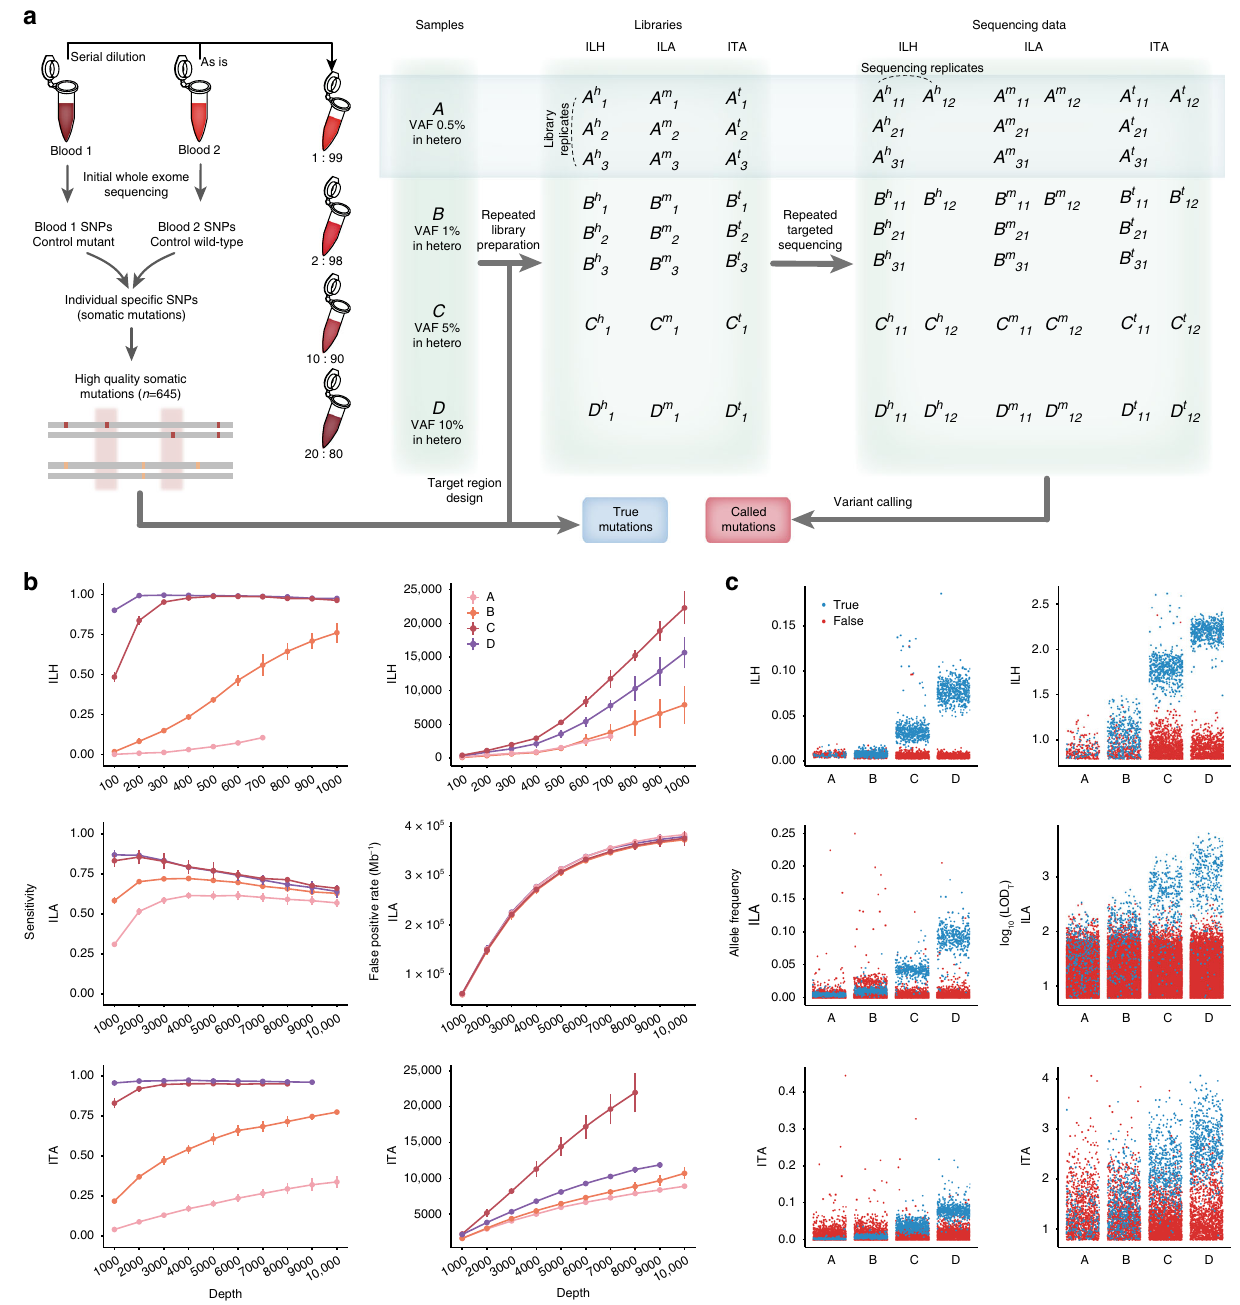
Fig. 1 Assessment of conventional algorithms for detecting mutations with low-allele frequency. a Schematic of experimental design for test-base sequencing data. Four distinct sample mixtures (A, B, C, and D) were prepared and sequenced with three different sequencing platforms (ILH, ILA, and ITA). Constructed libraries from each platform were sequenced twice to produce sequencing replicates (X 11 and X 12 ). For samples A and B, two independent sets of sequencing library were additionally prepared to sequence data from library replicates (X 21 and X 31 ). Each set of sequencing data was sequentially downsampled ten times to evaluate the effects of read depth. All generated datasets were analyzed, and average performances were reported for each depth and platform. b Sensitivity and FPR of conventional methods (MuTect with adjusted parameters, others in Supplementary Figs. 1 and 2) by sequencing depth and VAF for each sequencing platform. Points are depicted within the maximum depth of the sequencing data (Supplementary Table 1). Error bars, 95% con fi dence intervals. Source data are provided as a Source Data fi le. c Distribution of allele frequencies and probabilistic odd-ratio scores (LOD T ) for true-positive and false-positive calls for each sample mixture (colored by blue and red, respectively). ILH hybrid-capture-based Illumina sequencing, ILA amplicon-based Illumina sequencing, ITA amplicon-based Ion Torrent sequencing, VAF variant allele frequency, FPR false-positive rate